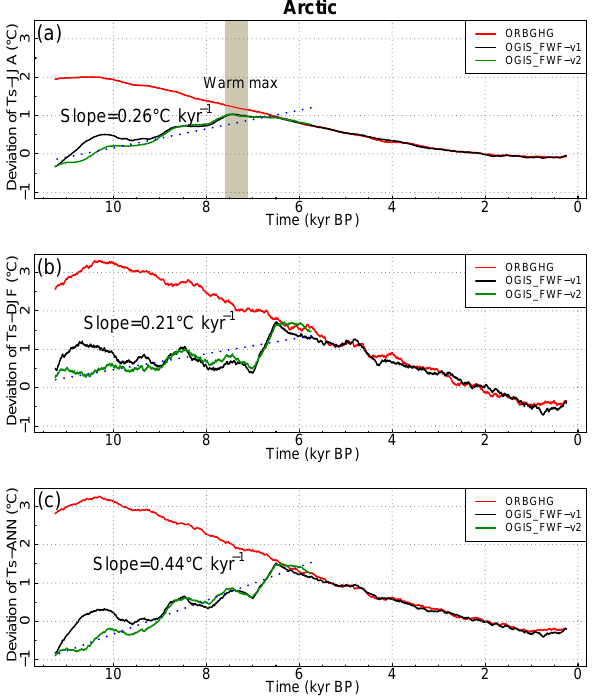
Figure 4. Simulated temperature evolution, shown as the anomalies compared to PI, since the early Holocene at high latitudes (north of 70 ◦ ). Panels (a) , (b) and (c) represent the summer, winter and an- nual values, respectively. The slope indicates the overall warming rate and is based on the least-squares regression over the period from the 11.5 to 6kyr, as from 6kyr the temperature starts to de- crease. It is only a general estimation, and thus uncertainty ranges are not provided. The warmest peak is marked by a shaded bar and represents the simulated peak during which the temperature was over 1 ◦ C higher than the PI. Both slope calculation and warm peak are based on the OGIS_FWF-2 simulation.